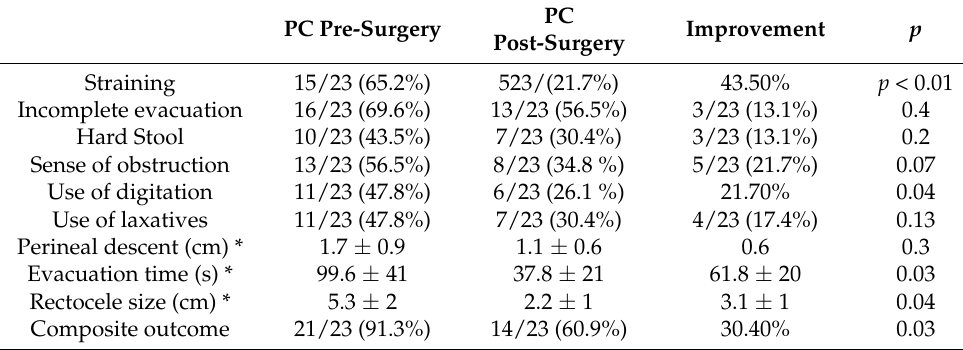
Table 5. Preoperative vs. postoperative evaluation in the PC